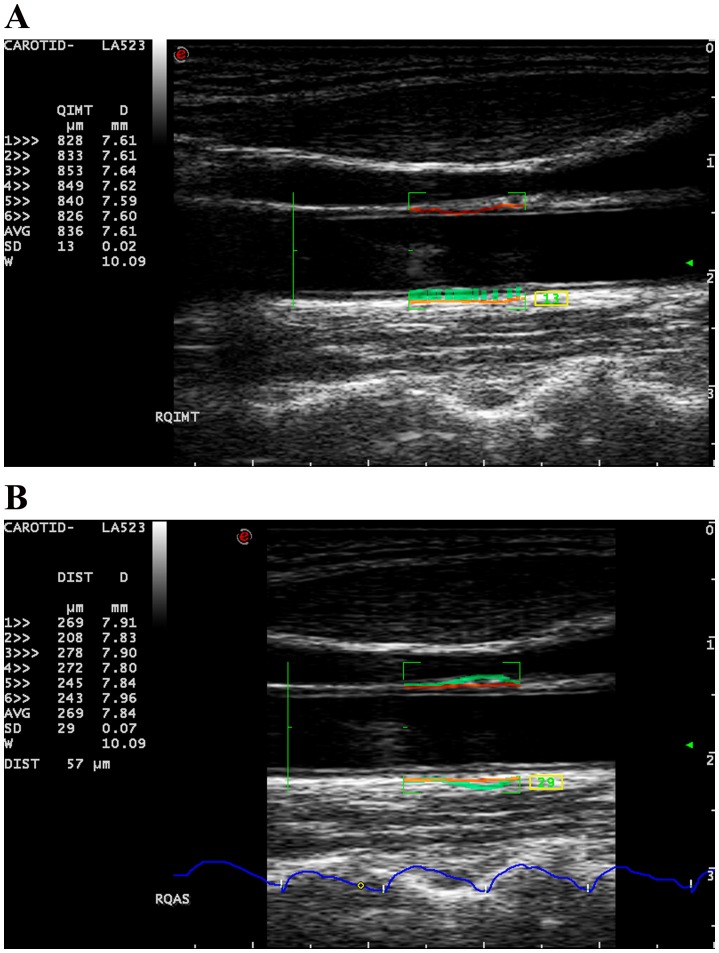
Measurements of carotid intima-media thickness and carotid arterial stiffness.
A). Carotid intima-media thickness is assessed at 1-cm segment 1 cm proximal to the inferior end of carotid bulb using Radiofrequency-based Quality Intima-Media Thickness. B). Carotid arterial stiffness is measured at the same segment using Radiofrequency-based Quality Arterial Stiffness.